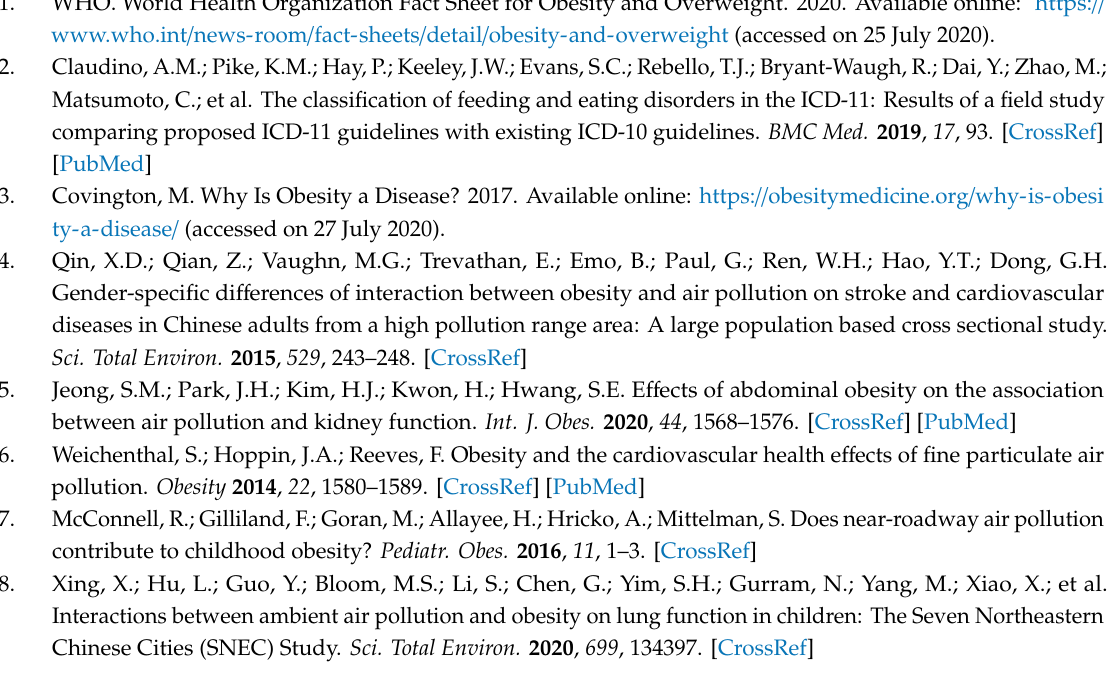
Table S1: Associations between obesity and particulate matters according to specific residence period among young adults in Community Health Survey, Seoul, Korea,